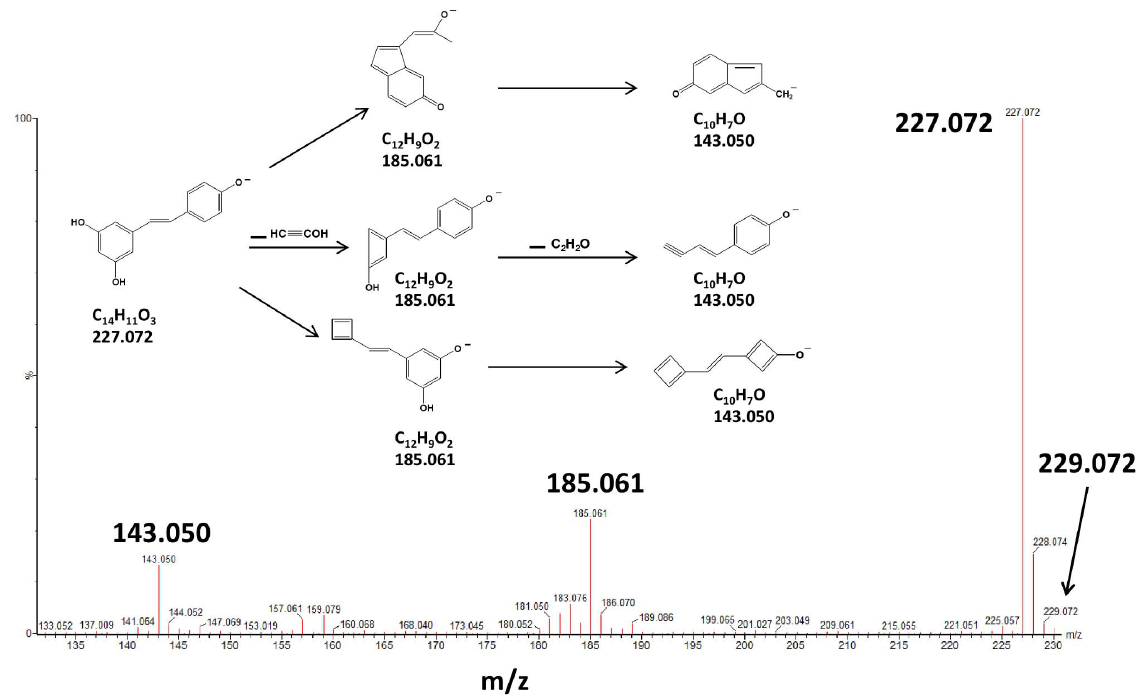
Figure 2. High-collision energy spectrum of ions specific to resveratrol, m/z 227.072, showing the daughter ions formed.